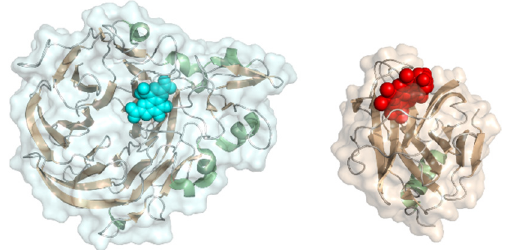
Figure 14. Crystal structure of Coprinopsis cinerea PQQ-dependent pyranose dehydrogenase with the dehydrogenase domain (PDB: 6JWF) colored in light cyan and the cytochrome domain (PDB: 6JT6) colored in light red. PQQ and heme b are shown as cyan and red spheres, respectively.